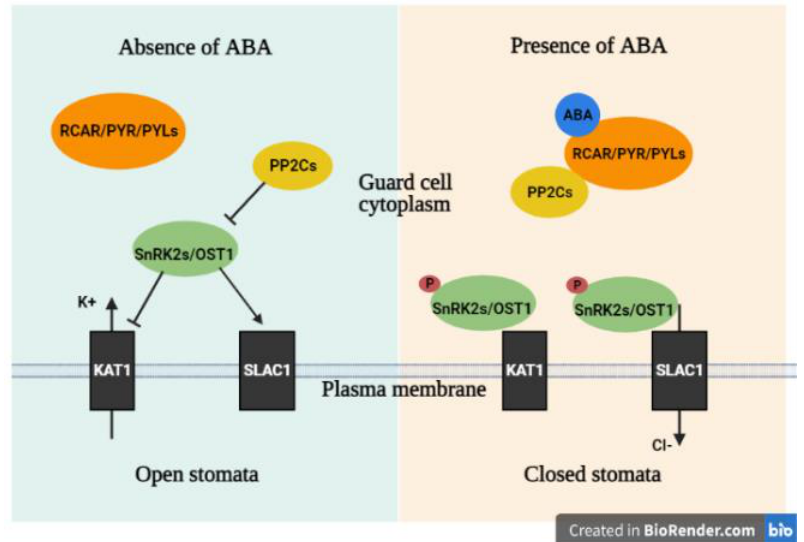
Figure 4. The mode of ABA regulating stomatal closure. Additional details are in the